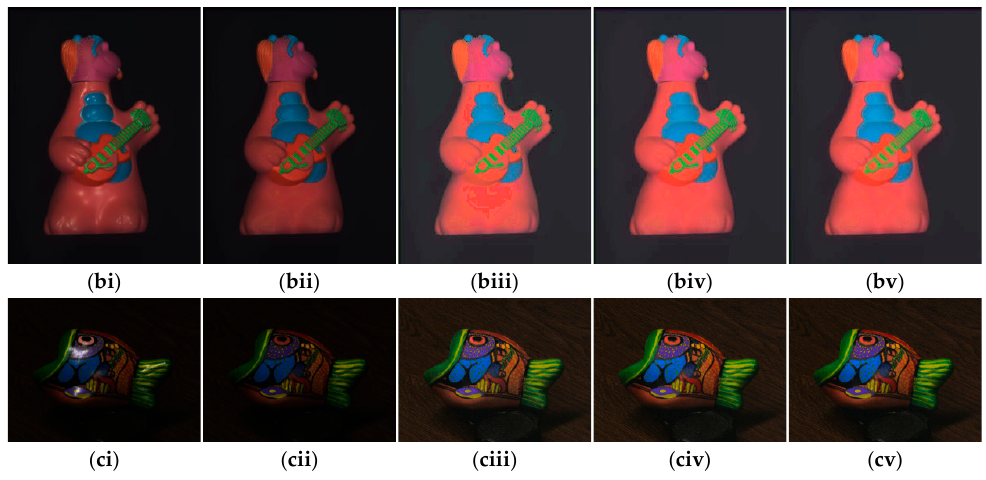
Figure 8. ( ai – ci ) Input LDR images ( Idol , Doll , and Fish ); ( aii – cii ) our HF images; ( aiii – ciii ) HDR images using Shen’s HF [22] images; ( aiv – civ ) our HDR images; and ( av – cv ) our HDR images by HLS